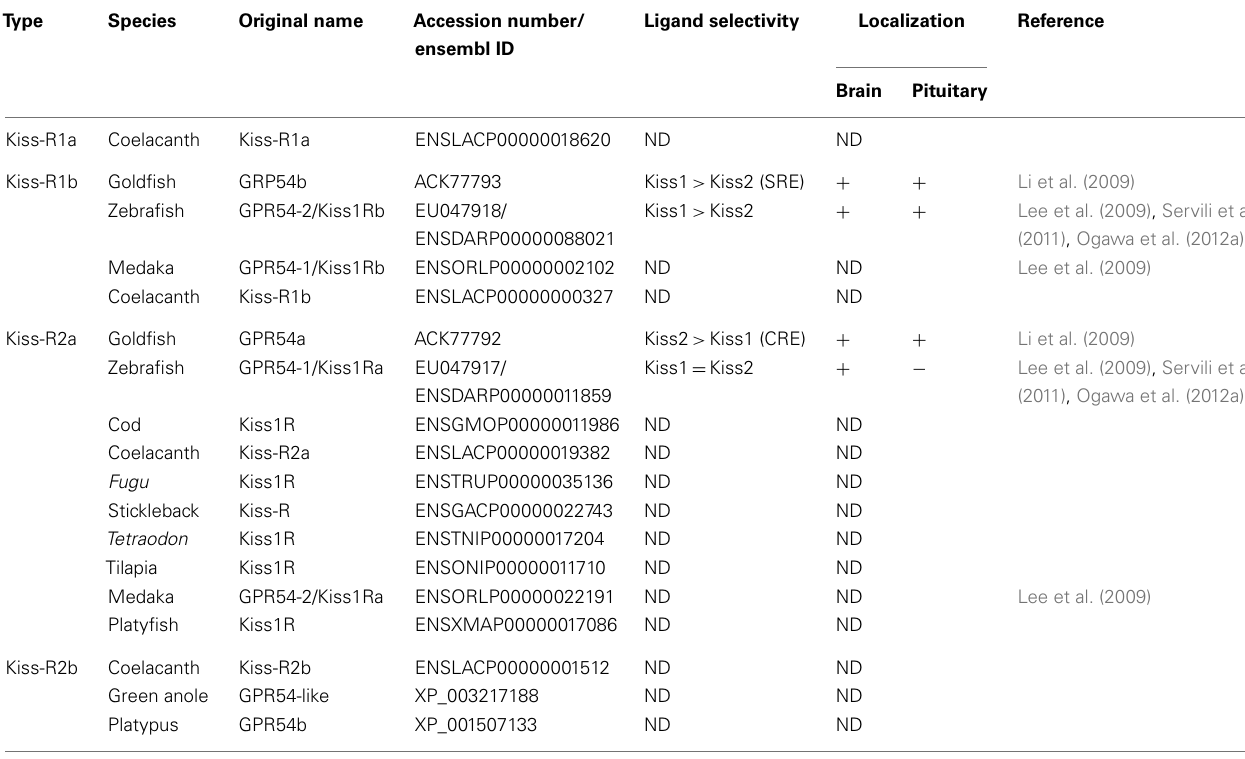
Table 2 | Kisspeptin receptors in